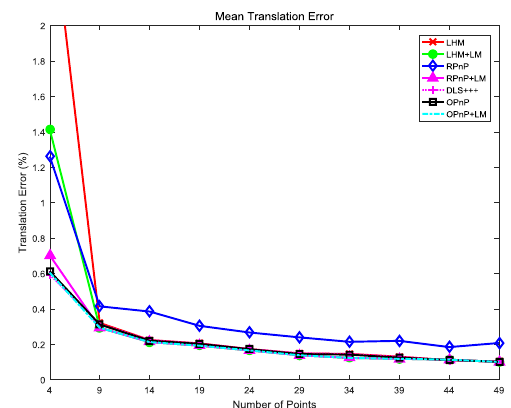
Figure 3. Mean translation error w.r.t. varying number of points